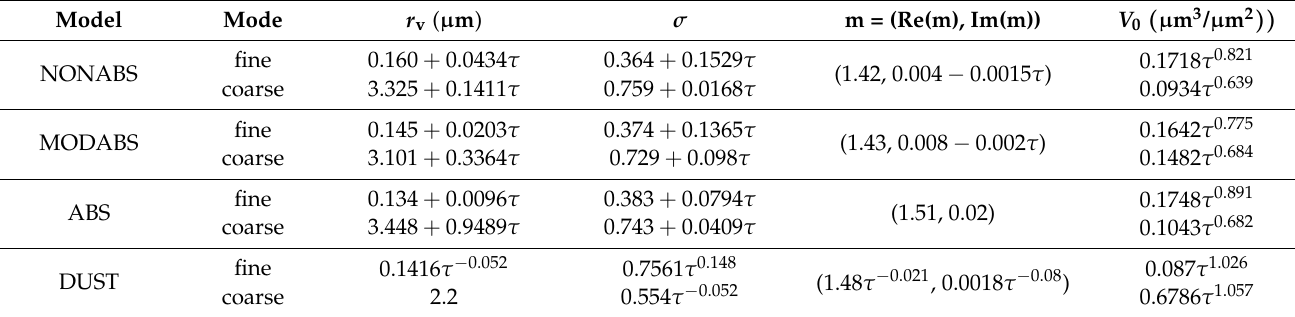
Table 1. Micro-physical properties of aerosols models of Set 1. Each model is composed of a fine and coarse mode. The median radius of the volume distribution r v , standard deviation σ , the volume of particles V 0 , and complex refractive index m of each mode are listed in the table.